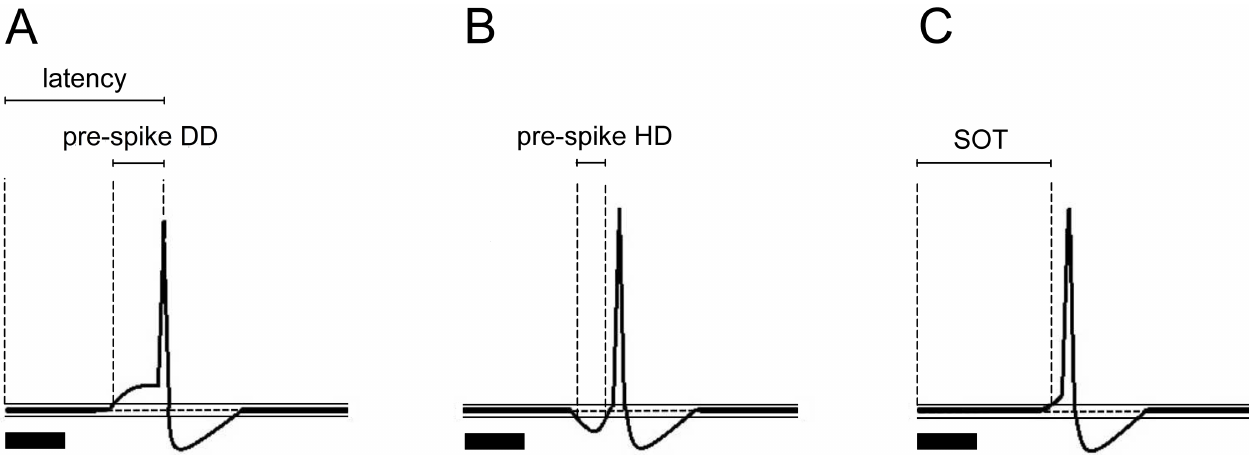
Fig 1. Calculation models of latency, pre-spike DD, pre-spike HD, and SOT. (A) Calculationmodel of latency and pre-spikeDD. (B) Calculation model of pre-spikeHD. (C) Calculationmodel of SOT. Horizontaldashed line on each baselineand two horizontalsolid lines above and belowthe baselines in A, B, and C show the resting potential (RP) and 95% confidencelimits. Solid lines on the aboveleft spikes show the pre-spike DD and latency in A, pre-spikeHD in B, and SOT in C. Solid black bar under the left side of panels A, B, and C representsthe pure tone stimulus.